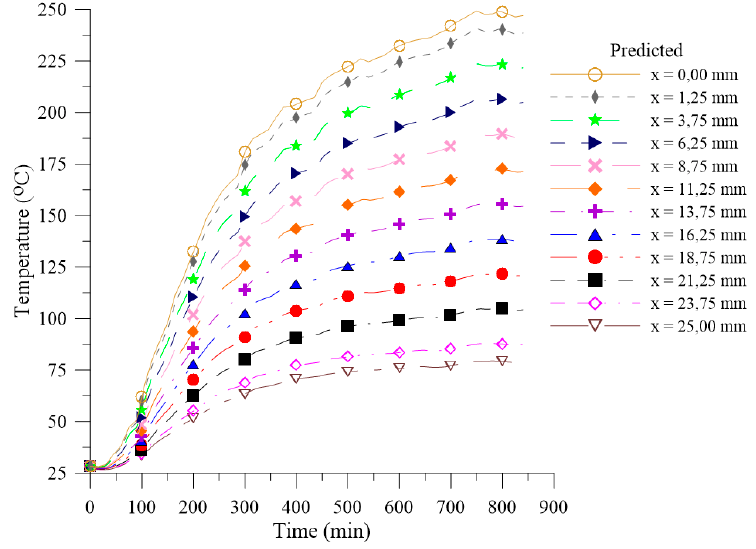
Figure 20. Temperature inside the thermal insulation as a function of time.